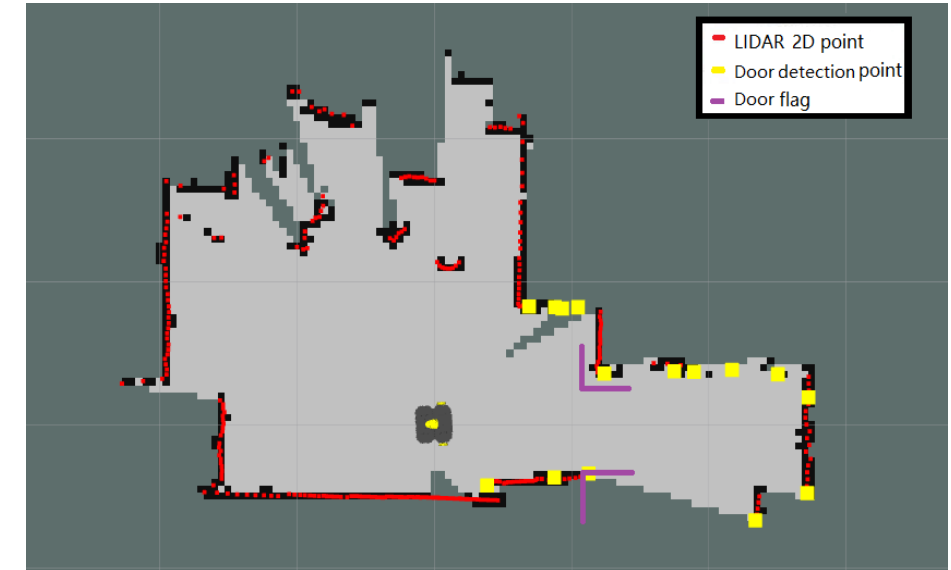
Figure 6. The application of LIDAR confirmation switching algorithm in 2D SLAM